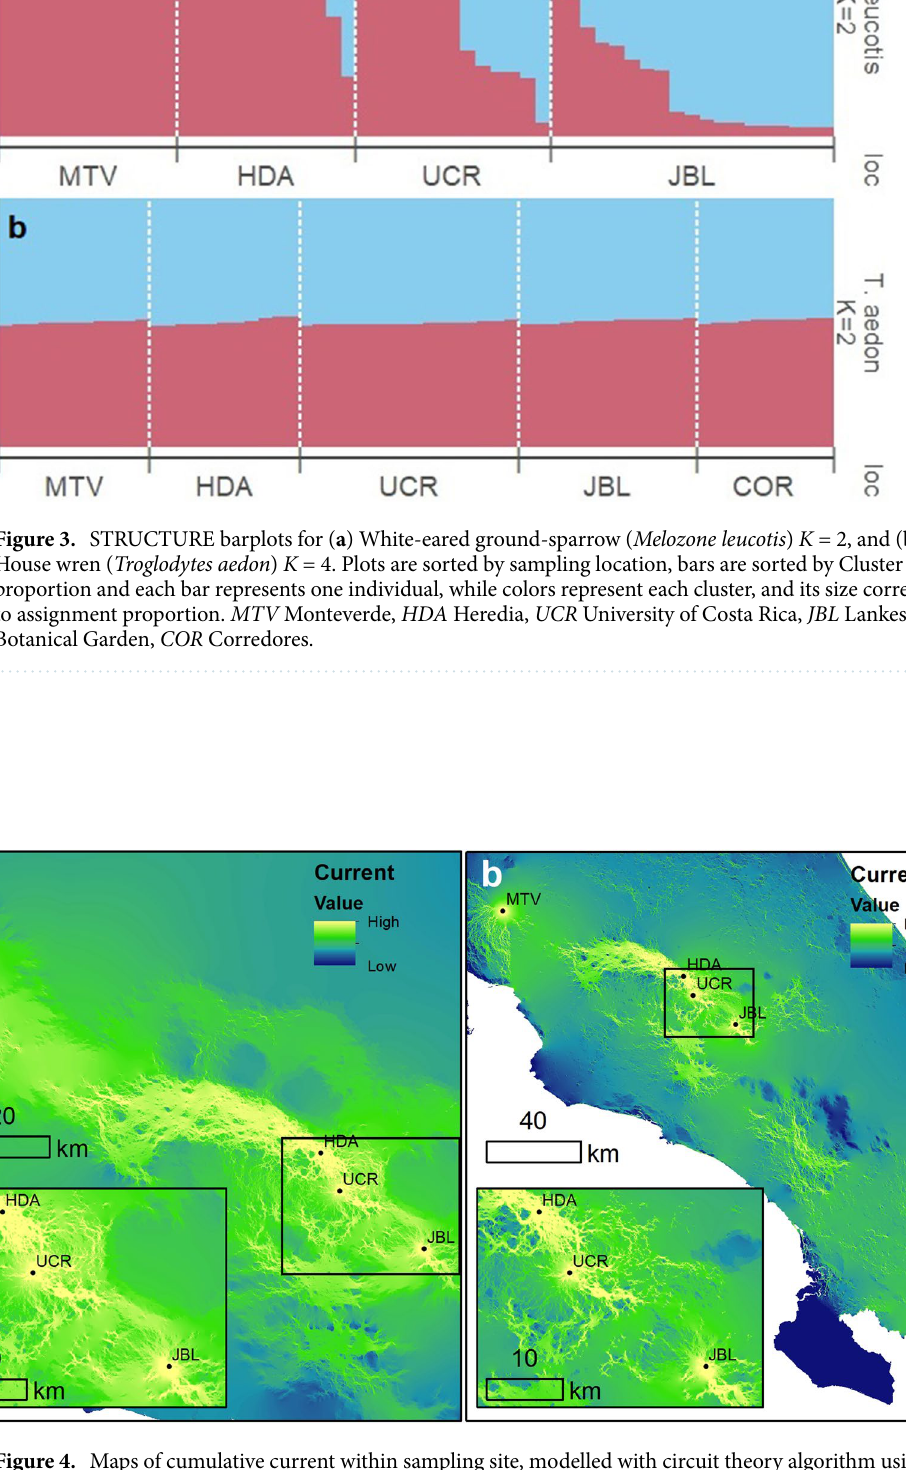
Figure 4. Maps of cumulative current within sampling site, modelled with circuit theory algorithm using Circuitscape 4.0, based on a land coverage layer of Costa Rica in 2005. Resistance values for each category are described on Supplementary Table S4. ( a ) corresponds to white-eared ground-sparrow ( Melozone leucotis ) sampling sites, and ( b ) house wren ( Troglodytes aedon ) sampling sites. MTV Monteverde, HDA Heredia, UCR University of Costa Rica, JBL Lankester Botanical Garden, COR